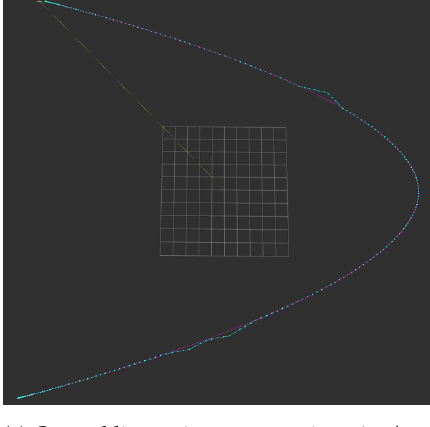
Figure 9. Replanning of global